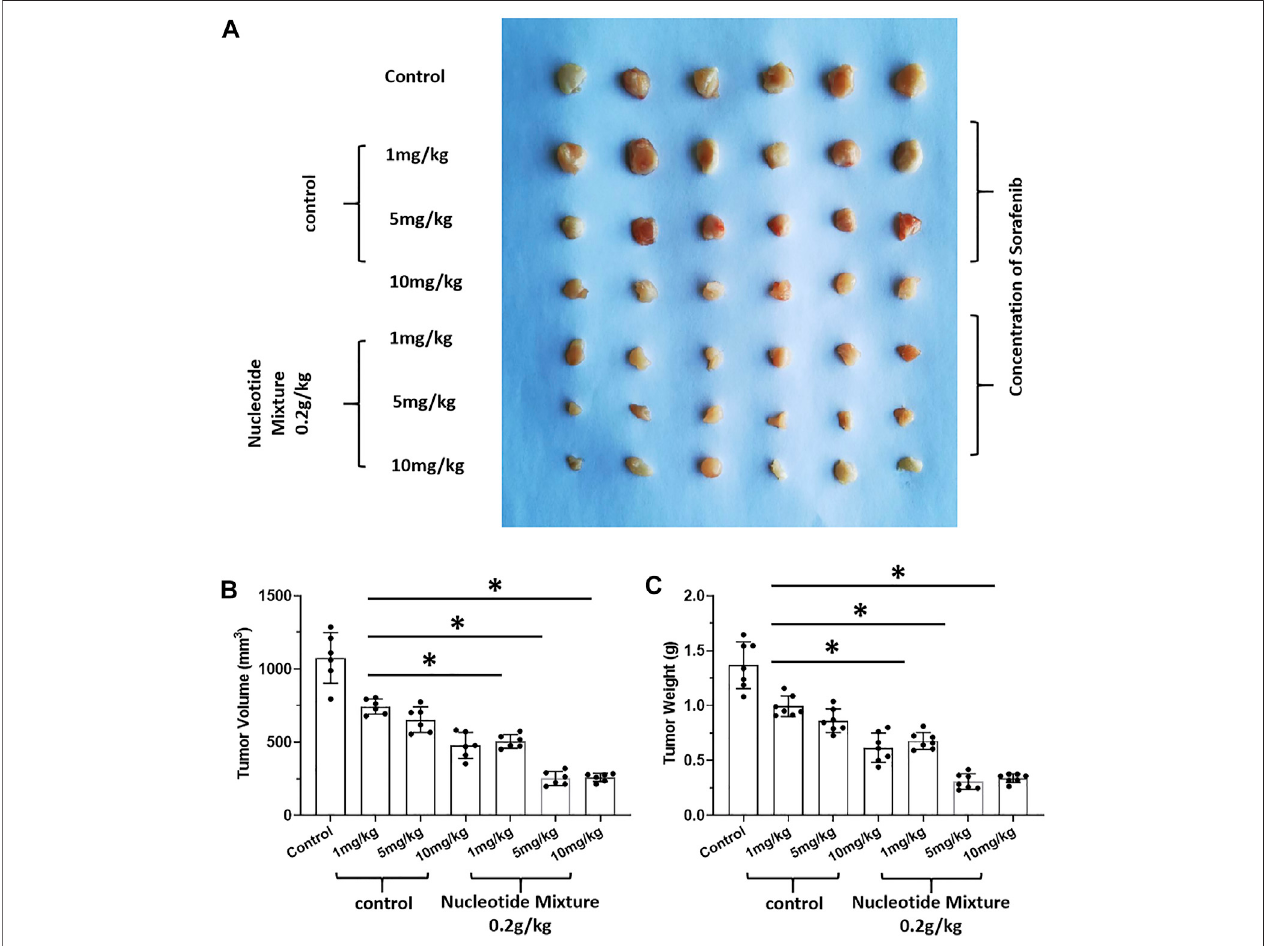
FIGURE 9 | Effect of the SNM on molecular-targeted drugs inhibiting the subcutaneous growth of murine HCC cells in BalB/c mice. H22 cells were obtained and inoculatedsubcutaneouslyinBalB/c mice.Then, mice weregivensorafenib(1, 5,10 mg/kg)aloneor combined withtheSNM (0.2 g/kg).Photographsofsubcutaneous tumors (A) , tumor volume (B) , and tumor weight (C) are shown. * p < 0.05.